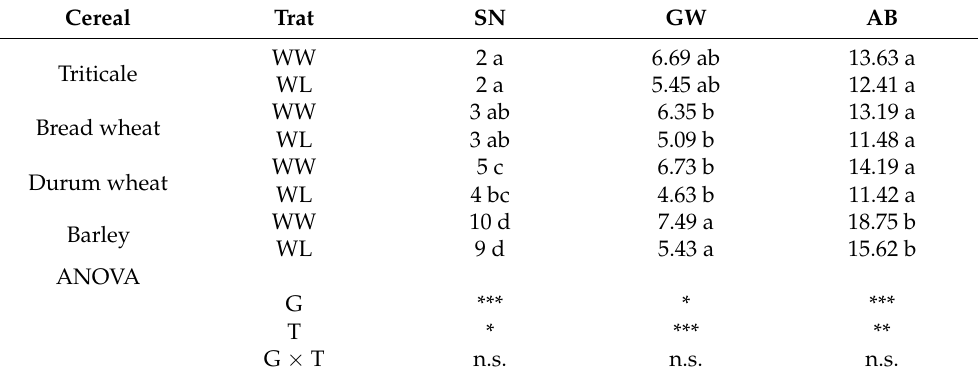
Table 2. Productivity traits: spike number (SN per plant), grain weight (GW, g plant − 1 ) and above- ground biomass (AB; g plant − 1 ) at harvest in triticale, bread wheat, durum wheat and barley grown under well-watered (WW) and water-limited (WL) conditions. G—genotype; T—treatment (water regime). Means with a common letter are not significantly